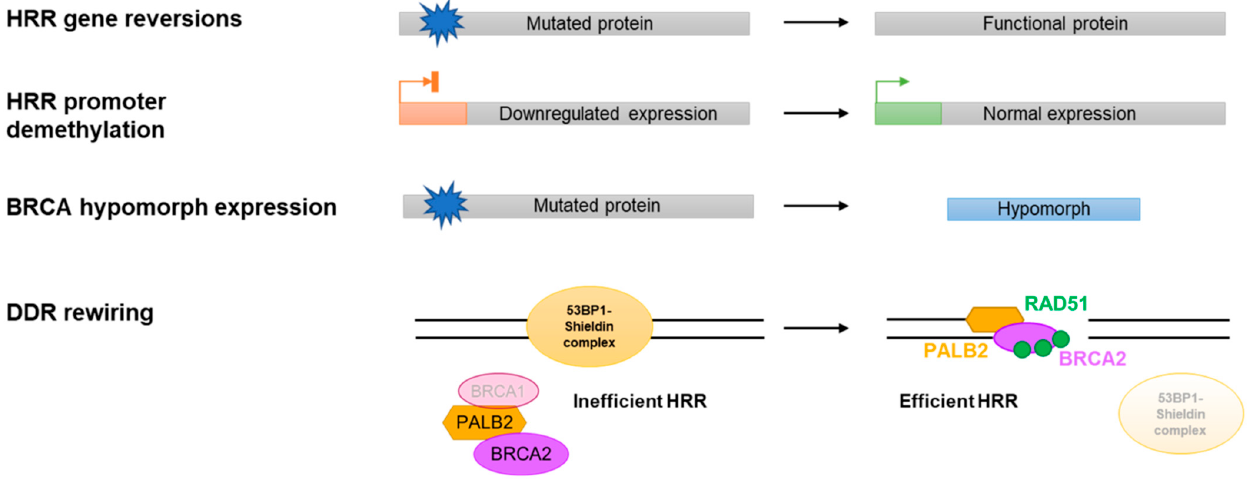
Figure 2. Representation of the mechanisms of PARPi resistance that depend on the HRR status of the cell.